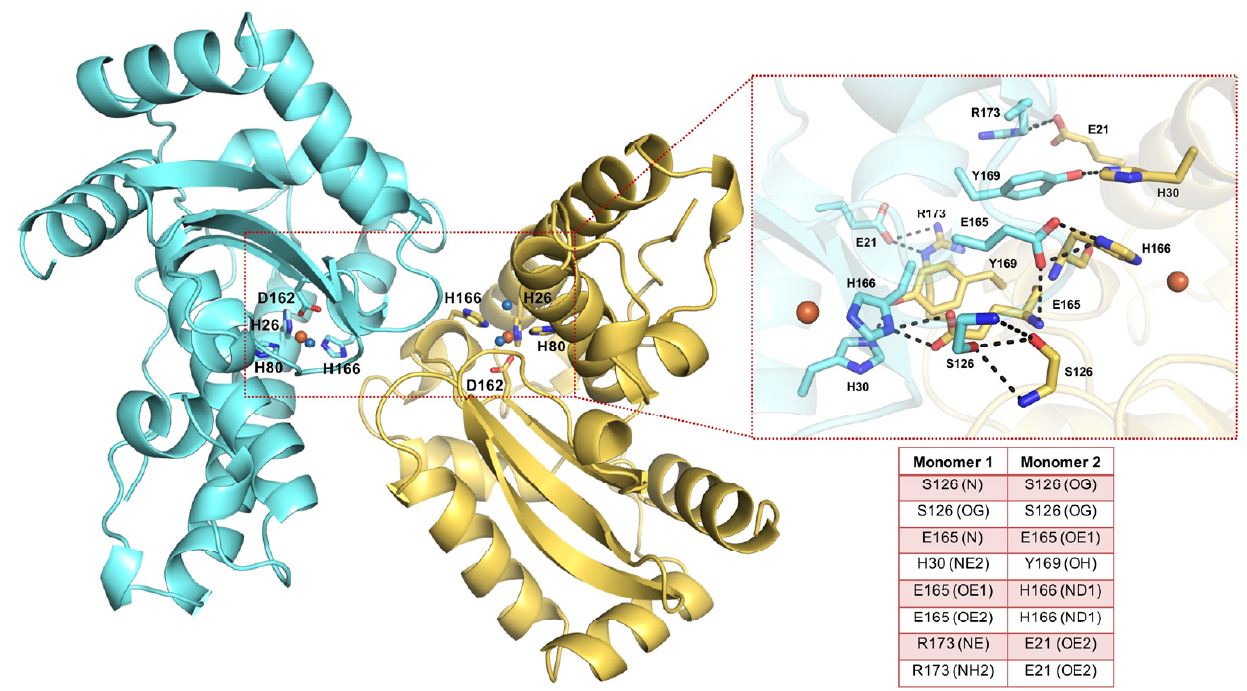
Figure 1. Overview of Sm SOD architecture and residues at the dimer interface. The X-ray structure of Sm SOD (PDB 4YIP) is shown as a ribbon model, with the two monomers coloured in aquamarine and yellow. The active site residues (H26, H80, H166, D162) are shown as sticks; the metal ion and the coordinating water molecules are shown as orange and blue spheres, respectively. On the right side, a zoom-in of the residues composing the dimer interface in which H-bonds are depicted as black dashed lines and listed in the inserted table.